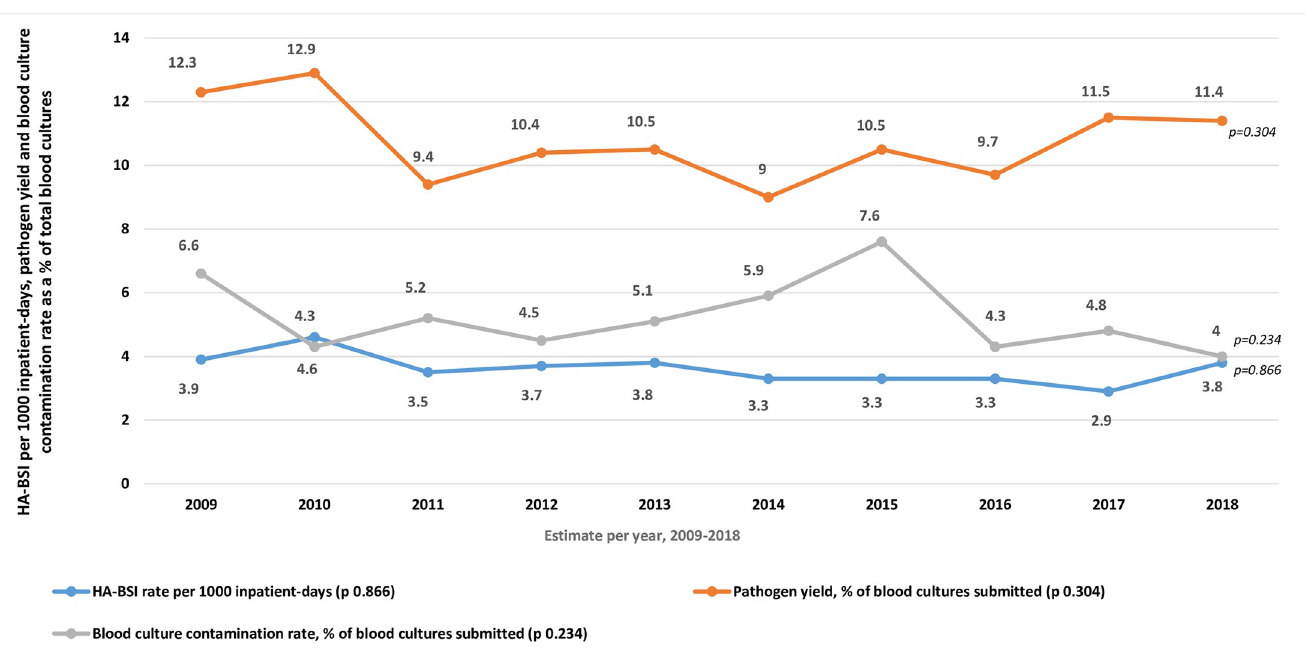
Fig 1. Trends in neonatal hospital-acquired bloodstream infection (HA-BSI) rate, pathogen yield and blood culture contamination rate (2009–2018). � HA-BSI rate calculated using number of HA-BSI episodes over total inpatient-days multiplied by 1000, from 2009–2018. HA-BSI comparisons made using Poisson regression. Pathogen yield and blood culture contamination rate calculated as number of pathogen-containing and contaminant-containing blood cultures respectively, as a proportion of all blood cultures submitted from 2009–2018; compared using a χ 2 test for linear trend. Two-sided p-values were used.